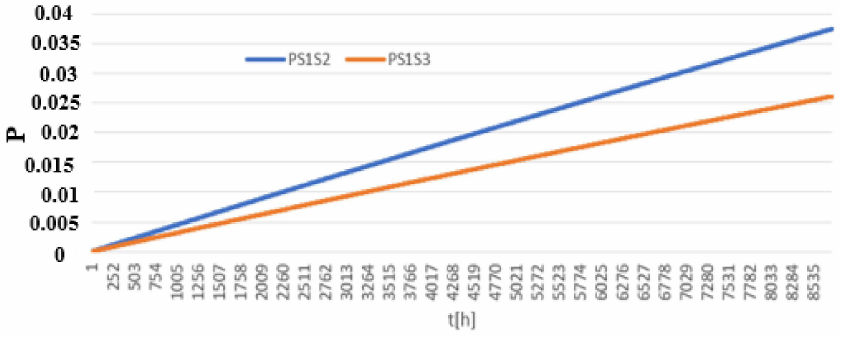
Figure 9. Probability of FAS transitioning from state S1 to states S2 and S3.